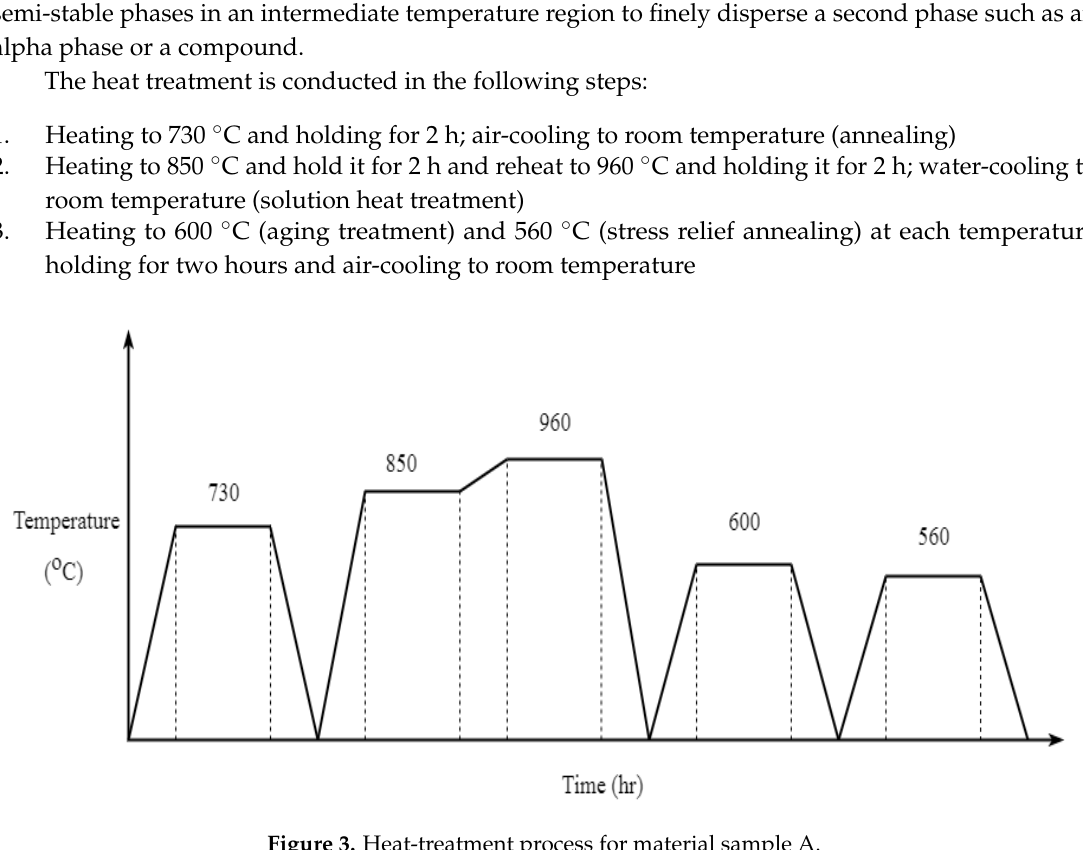
Figure 3. Heat-treatment process for material sample